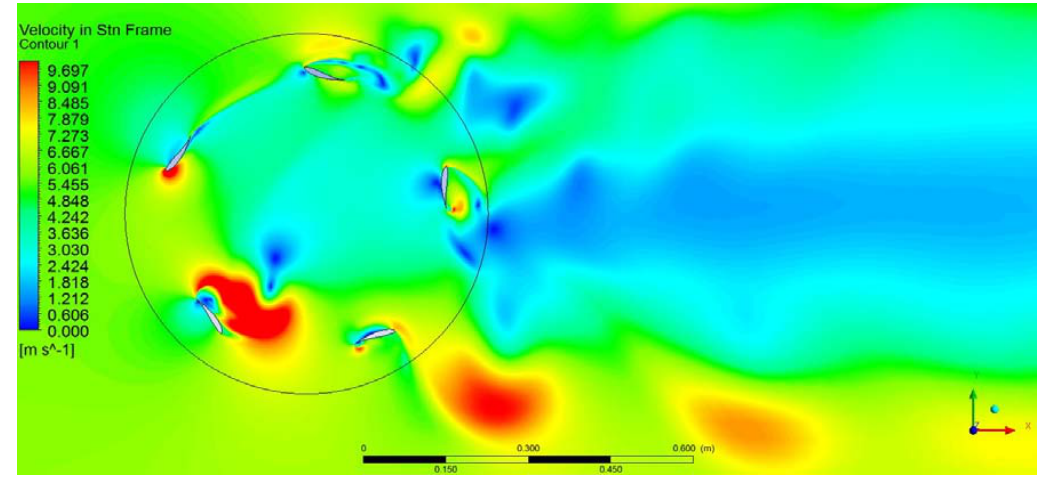
Figure 18. Contour of velocity magnitude for open rotor.